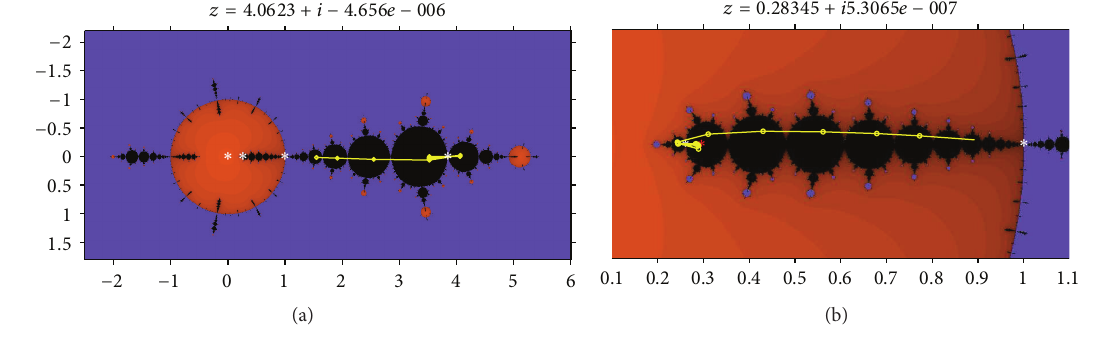
Figure 5: Two 2-cycles in the dynamical plane for 𝛼 = 3.55